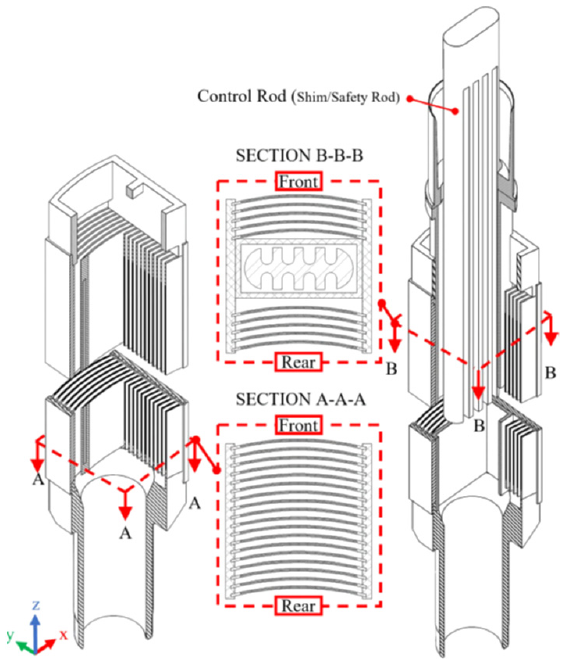
Figure 3. Sketch of (F) left and (C) with an inserted CR (shim/safety rod) right. Figure is taken from [13].